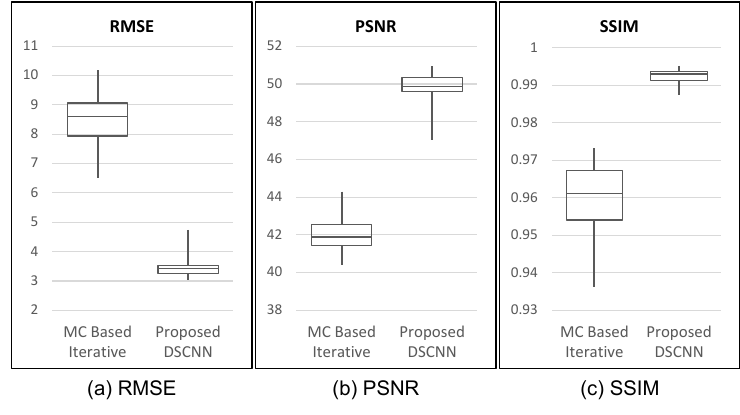
Figure 7. Box and whiskers plots of Table 3.